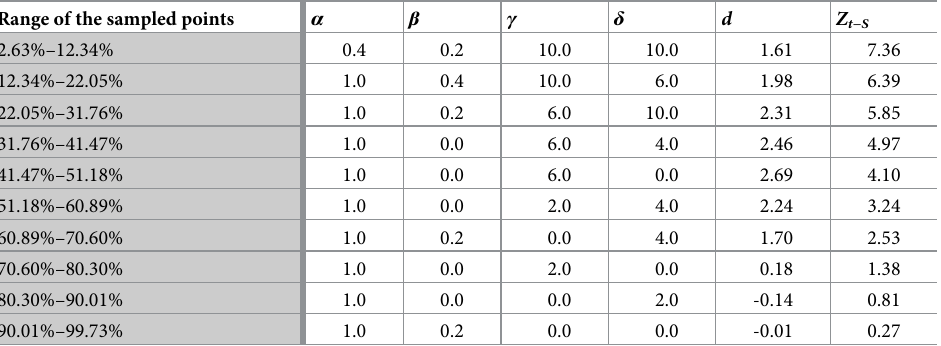
Table 1. Best sampling for each range of selected points ( n S ).